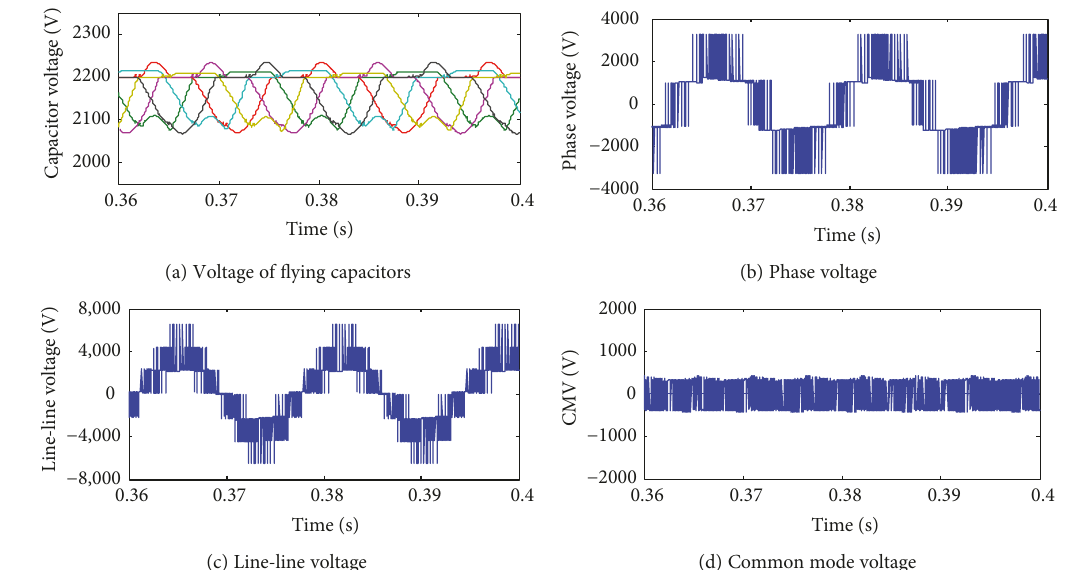
Figure 7: Simulation results (proposed solution).